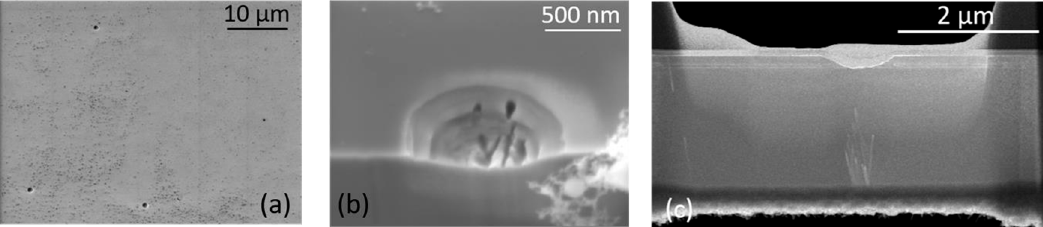
Figure 4. Laser induced holes on the p -GaN side after laser treatment. ( a ) Overview picture, showing three laserinduced holes, ( b ) close-up cross-sectional view of a hole under 30° tilt, which has a depth of several 100 nm, meaning that the p-GaN layer and the multi quantum well are locally destroyed. ( c ) TEM image revealing a local accumulation of threading dislocations underneath the